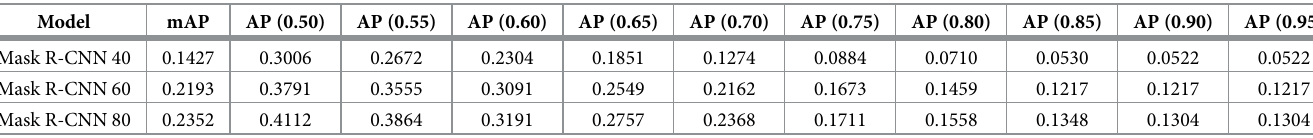
Table 4. Performance comparison between the Mask R-CNN segmentation models.